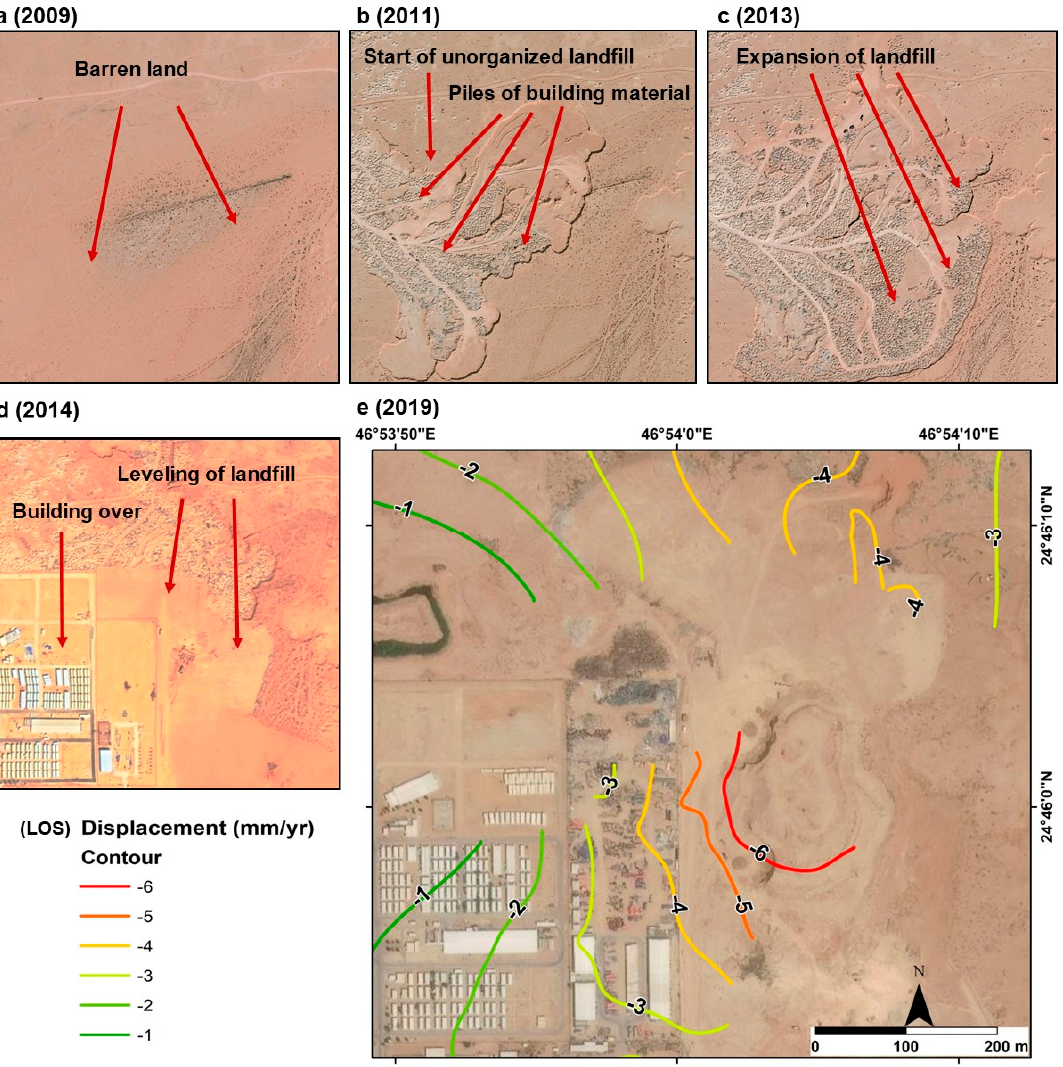
Figure 10. Temporal Google Earth images (2009 to 2014), ArcGIS online base map (2019), and LOS velocities over a sandstone and alluvium dumpsite (site D1) in Ar Rimayah District. ( a ) Google Earth image acquired in May 2009. ( b ) Google Earth image acquired in December 2011. ( c ) Google Earth image acquired in February 2013. ( d ) Google Earth image acquired in November 2014. ( e ) LOS deformation rates plotted over the 2019 ArcGIS online base map.